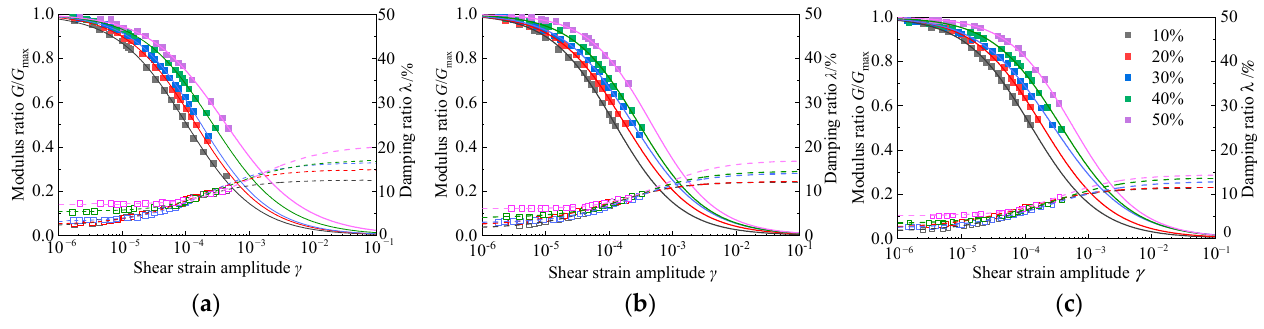
Figure 24. The G / G max ~ γ and λ ~ γ curves of RCS soil with different rubber contents. ( a ) C = 3.5 g/100 mL, σ 'm = 50 kPa, (b) C = 3.5 g/100 mL, σ 'm = 100 kPa, ( c ) C = 3.5 g/100 mL, σ 'm = 150 kPa. σ (cid:48) m = 50 kPa, ( b ) C = 3.5 g/100 mL, σ (cid:48) m = 100 kPa, ( c ) C = 3.5 g/100 mL, σ (cid:48) m = 150